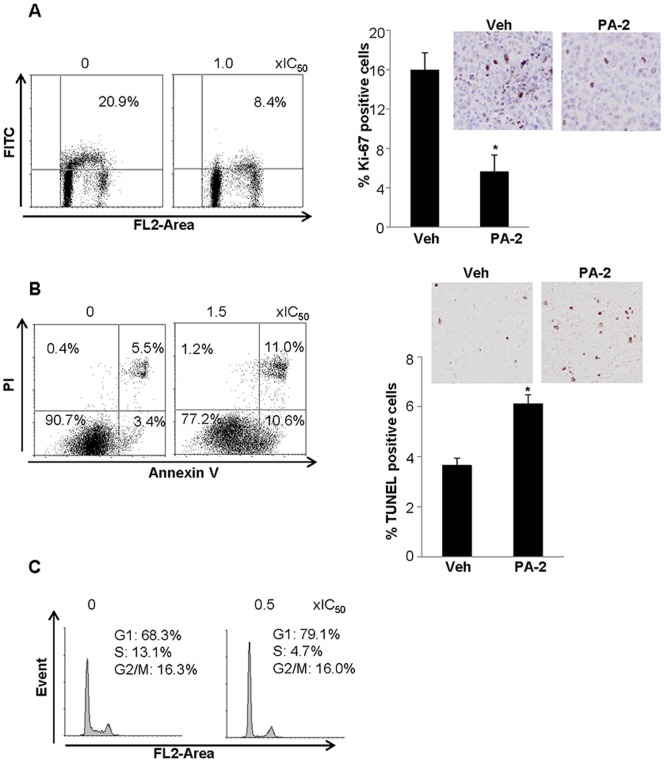
Phospho-aspirin-2 exerts a triple cytokinetic effect on MCF7 cells.A: Left: MCF7 cells were treated PA-2 for 24 h and the percentage of proliferating cells was determined by BrdU incorporation. Right: The percentage of proliferating cells in vehicle or PA-2 treated MCF7 xenografts were determined by Ki-67 staining. Representative images (top) and the quantification (bottom) of Ki-67 expression in tumor sections, * p<0.007. B: Left: MCF7 cells treated with PA-2 for 24 h were stained with Annexin V/PI, and the percentage of apoptotic cells was determined by flow cytometry. Right: The percentage of apoptotic cells in MCF7 xenografts were determined by TUNEL assay. Representative images (top) and the quantification (bottom) of TUNEL positive cells in tumor sections, * p<0.002. All values are mean ± SEM. C: PA-2 blocks the G1/S cell cycle phase transition after 24 h treatment in MCF7 cells, determined by flow cytometry following PI staining.